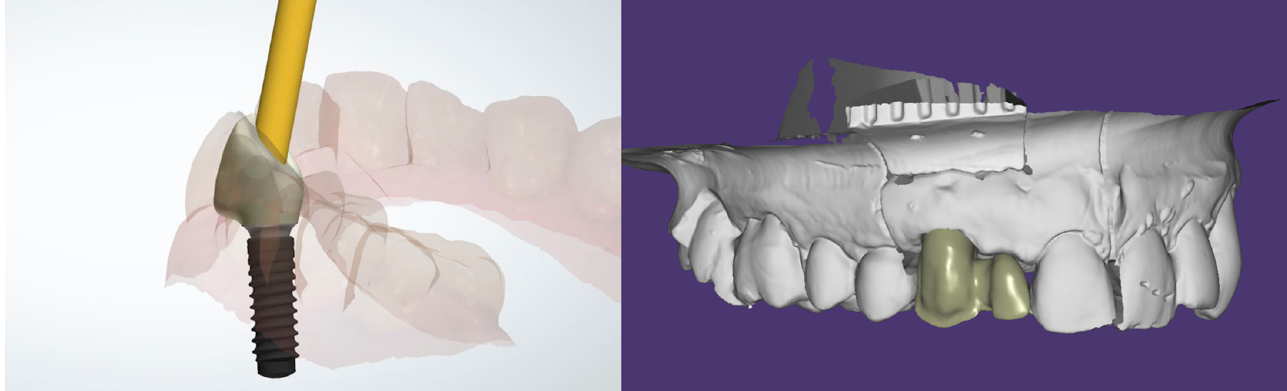
Figure 1. The digital project of a monolithic zirconia crown and a zirconia framework later veneered (0.8 mm cutback).